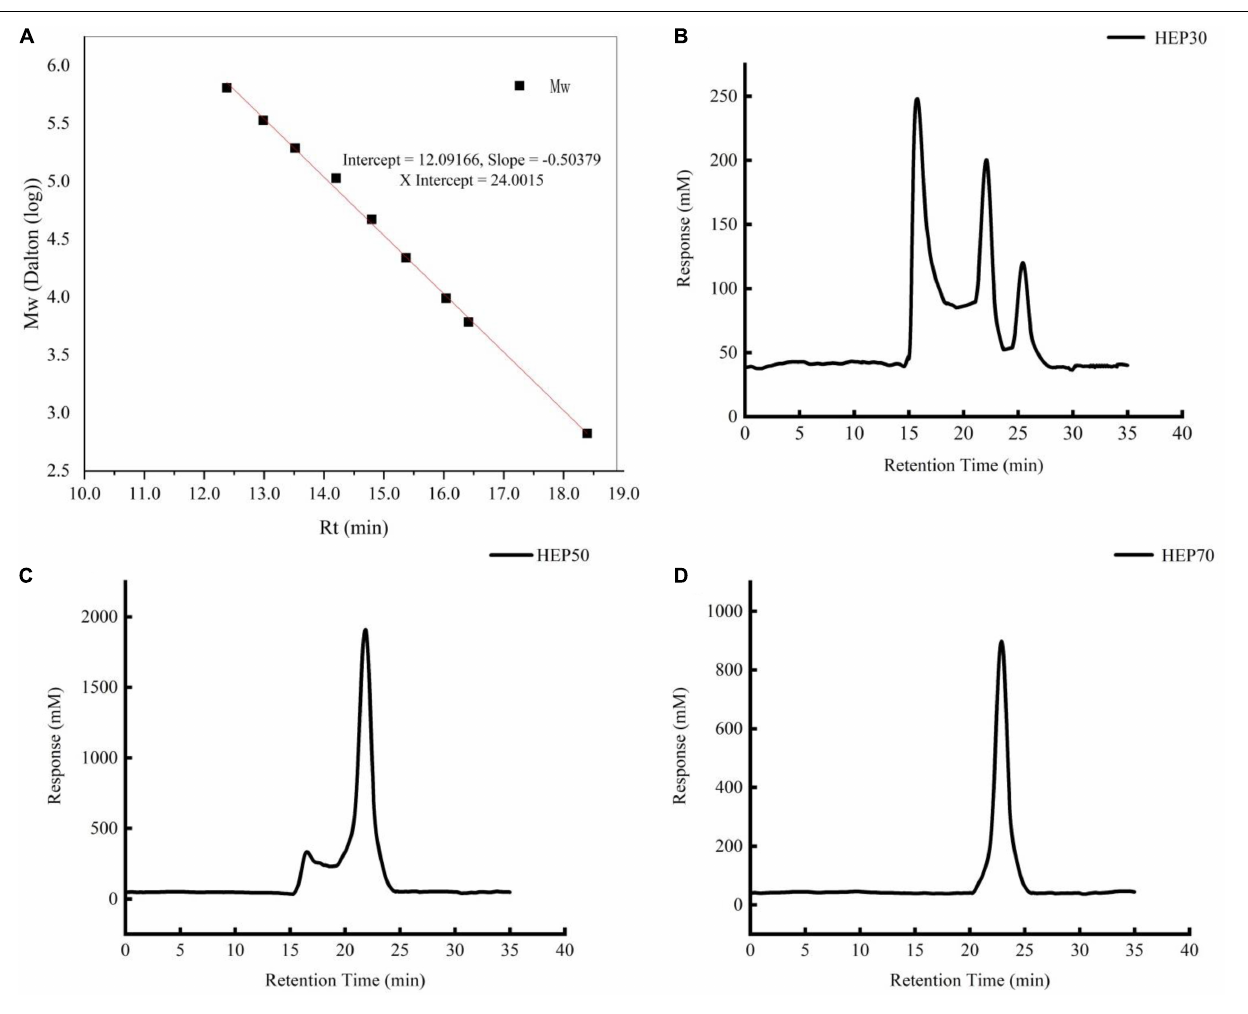
molecular weight segment). Lastly, HEP-70 was relatively pure, with a molecular weight of 4.771 ± 0.21 kDa (95.18% of the total molecular weight). The monosaccharide composition of HEPs is shown in Table 2 . All the three grades of HEPs were composed of similar monosaccharide composition in a slightly different molar ratio. The monosaccharide composition of HEP-30 is in the molar ratio of fructose: mannose: glucose: galactose = 0.3: 1.3: 9.8: 0.3; HEP-50 is 1.7: 0.5: 10.6: 10.4; and HEP-70 is 1.2: 1.3: 23.7: 0.3.